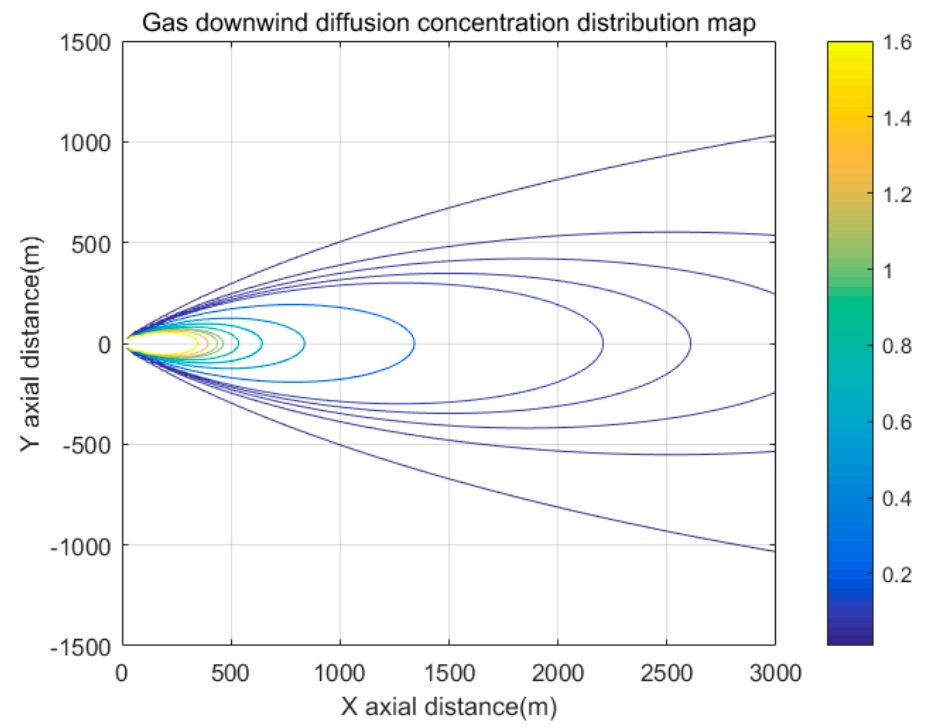
Figure 2. Concentration distribution of hazardous chemicals after leakage in windy conditions.